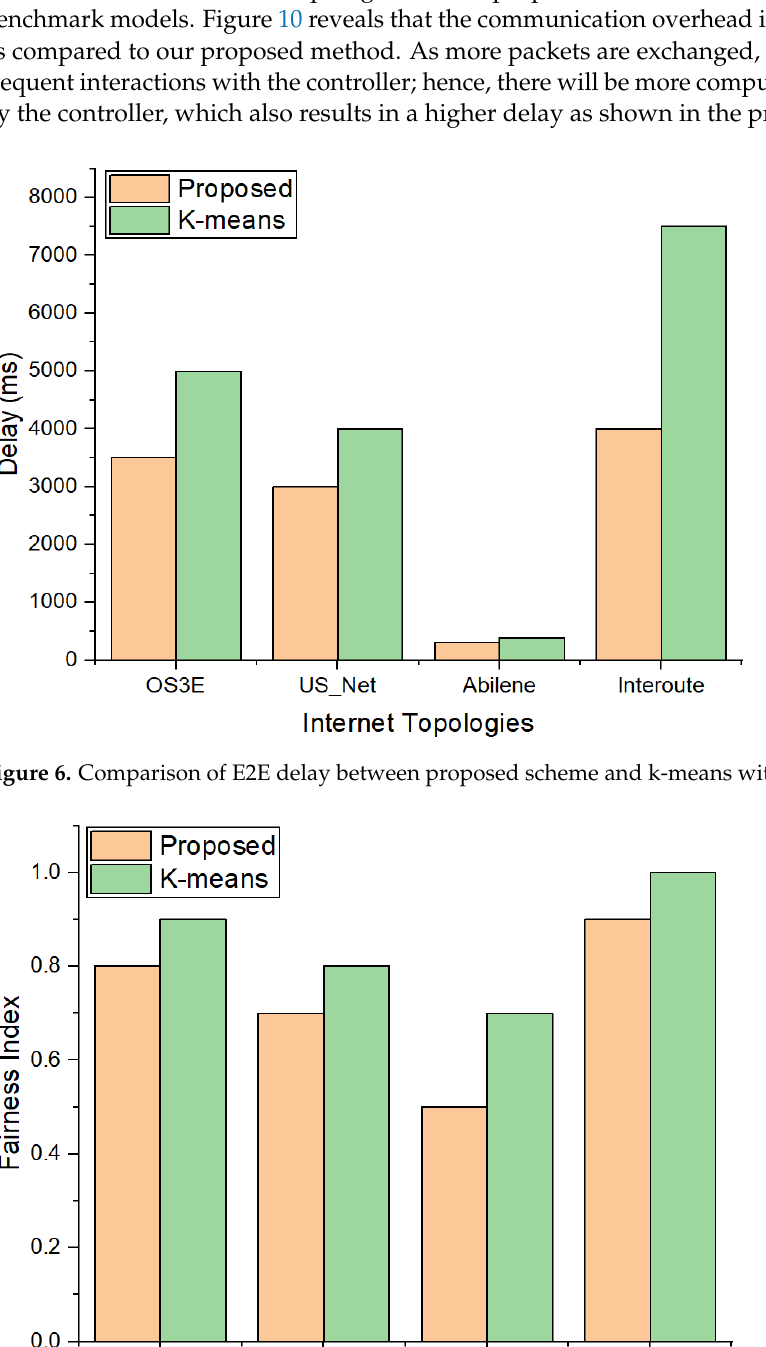
Figure 7. Comparison of the fairness index between k-means and proposed approach.